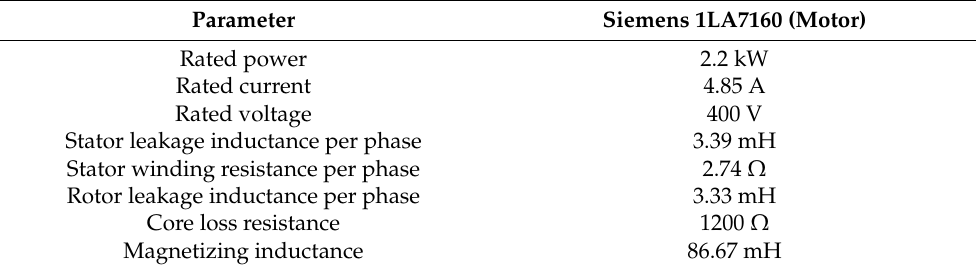
Table 1. Parameters of the model and laboratory stand motor.